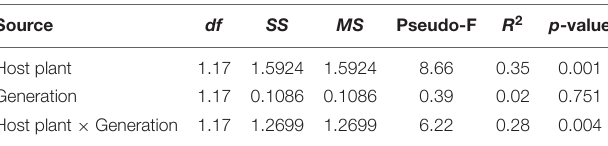
TABLE 3 | PERMANOVA of the bacterial communities of C. medinalis fed rice or maize for three generations.